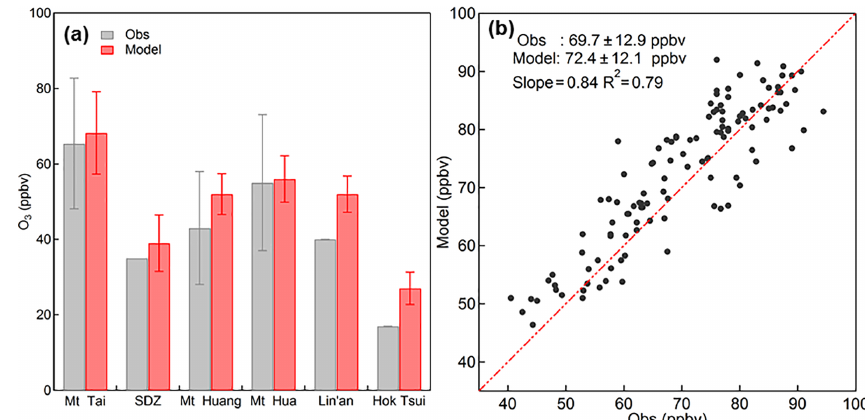
Figure 1. (a) Comparison of observed and simulated monthly mean concentrations of surface O 3 in July 2003. (Mt. Tai: July 2003; SDZ: Shangdianzi station: July 2004; Mt. Huang: July 2004; Mt. Hua: July 2004; Lin’an: July 2004; Cape D’Aguilar (or Hok Tsui in a ): July 2003). (b) Correlation between observed and modeled monthly mean MDA8 O 3 in July 2015 at 115 stations in eastern China.